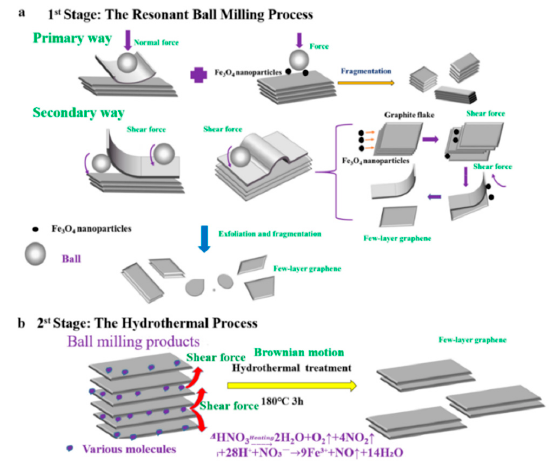
Figure 1. Illustration mechanism of the prepared few-layer graphene (FLG) nanosheets by two-step method with Fe 3 O 4 nanoparticles. ( a ): the mechanism of exfoliated by the resonant ball- milling with Fe 3 O 4 nanoparticles, ( b ): the mechanism of exfoliated by the hydrothermal